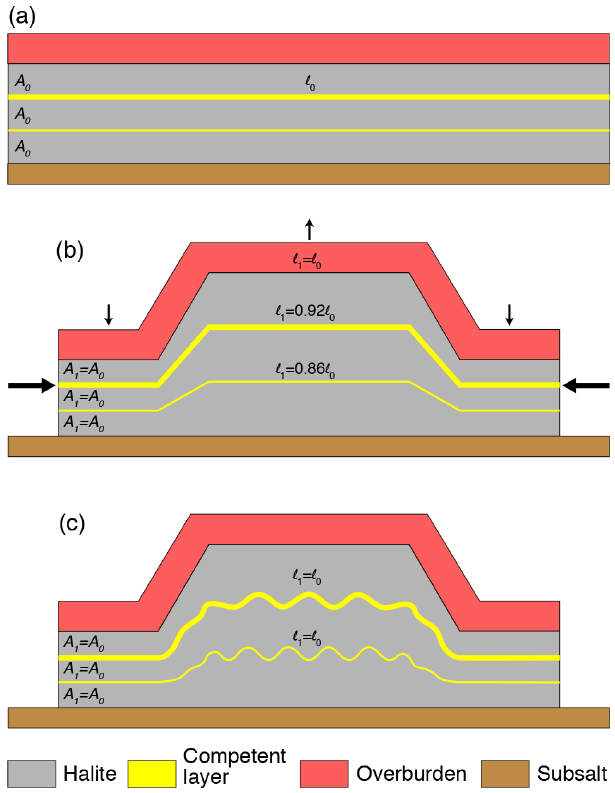
Figure 6. Conceptual diagrams of plane-strain layer-parallel short- ening: (a) undeformed salt layer with two competent internal beds (yellow), with different thicknesses and of length l 0 , that divide the halite into three layers with equal area A 0 ; (b) shortening of 14% generates folded overburden (box fold for simplification), with thickening of salt in core of anticline and thinning beneath syn- clines; maintaining halite areas, with no breaking or folding of the strong beds, results in apparent decrease in line length of the com- petent beds; (c) more realistic scenario of buckle folds in competent beds, with the amount of internal shortening increasing downward to maintain bed length – note the longer wavelength in the thicker strong